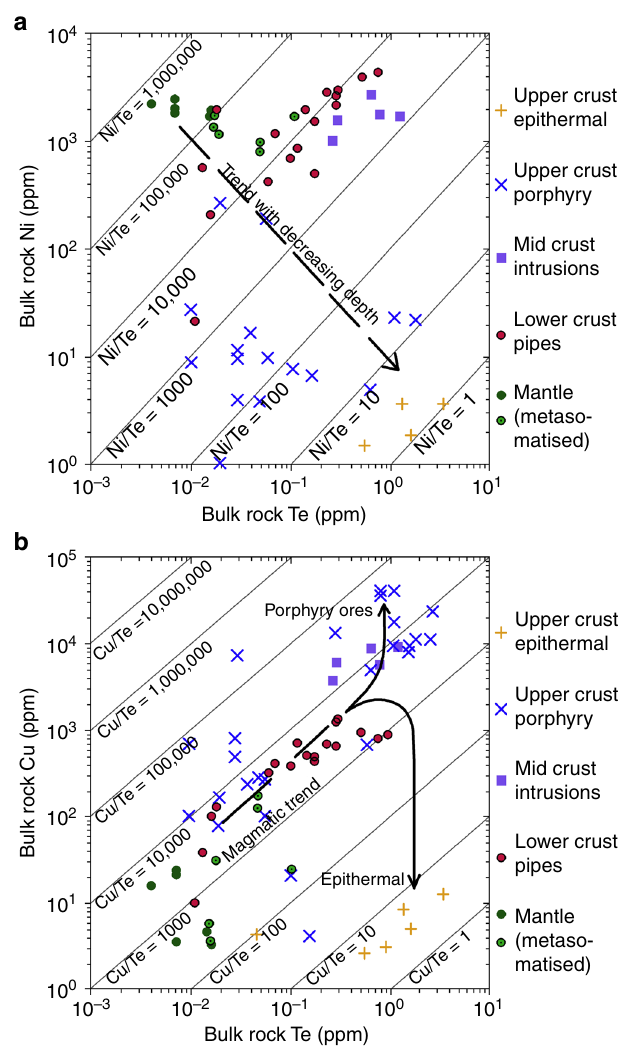
Fig. 2 Tellurium/nickel and copper ratios through the lithosphere. a Plot of Te vs. Ni showing increase in Te/Ni up through the lithosphere with fractionation; and b plot of Te vs. Cu showing divergent behaviour in the hydrothermal